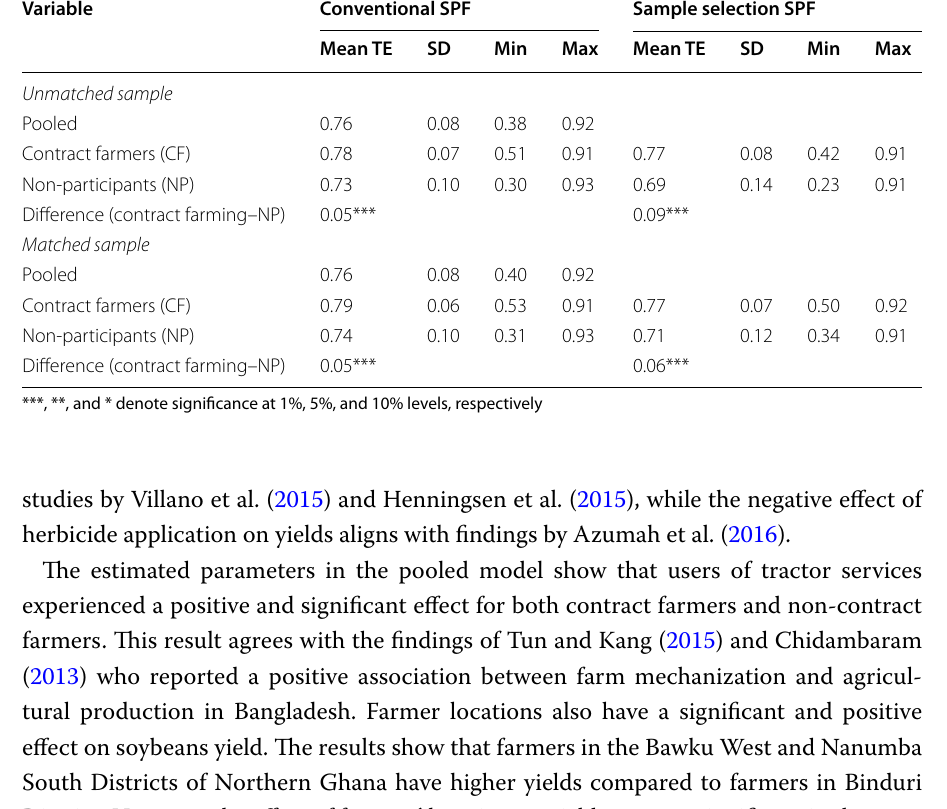
Table 5 T tests of technical efficiency using matched samples